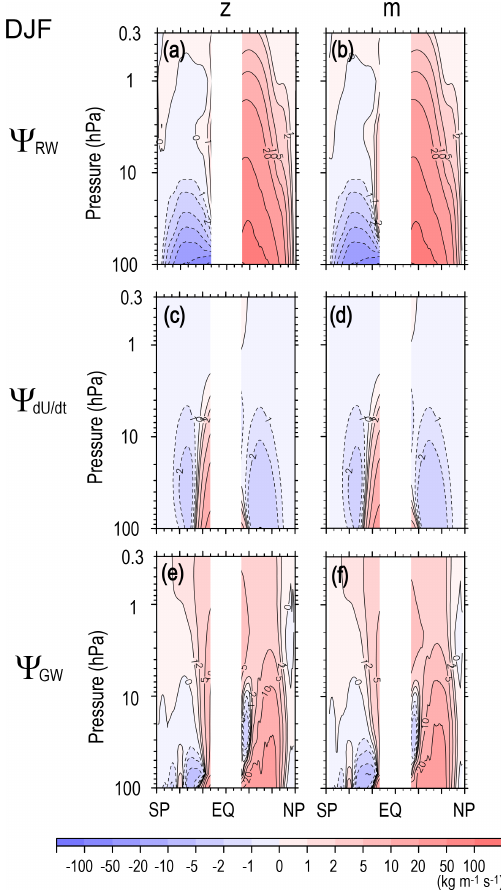
Figure B1. Meridional cross sections of the DJF climatology of potential contributions by (a, b) the RWs, (c, d) the tendency of zonal mean zonal wind, and (e, f) the GWs in DJF estimated from MERRA-2. Estimates from (a) , (c) , and (e) a vertical integral at a constant latitude (i.e., ignoring vertical advection of momentum) and from (b) , (d) , and (f) a vertical integral along a constant angular momentum ( m ).